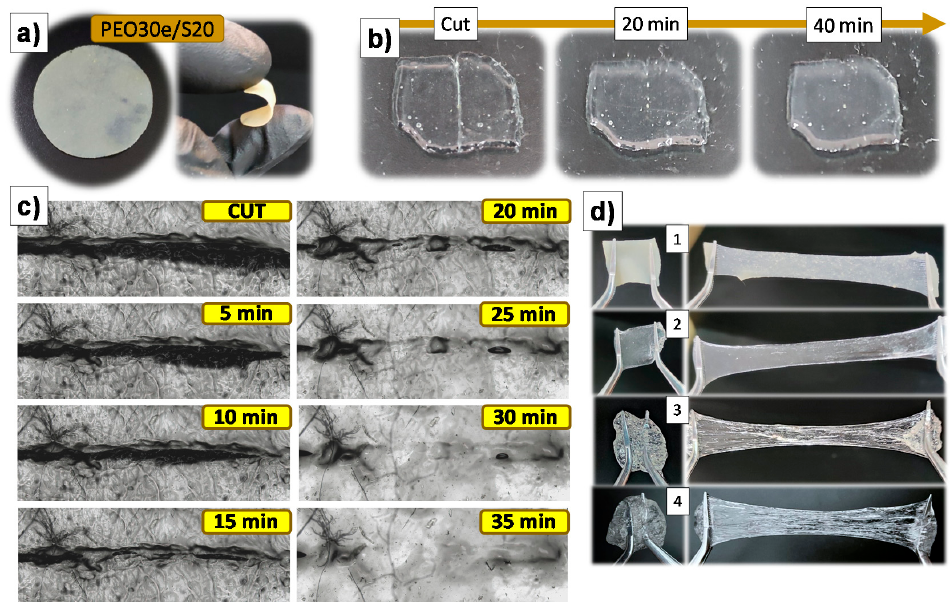
Figure 1. Pictures of the gels illustrating different properties: ( a ) films of flexible PEO30e/S20; ( b ) self-healing ability of PEO30e, and ( c ) optical profilometry images at 5× magnification of PEO30e, ( d ) stretching of PEO30e/S20 ( 1 ), PEO30e ( 2 ), PEO5e ( 3 ) and PEO5e/Na ( 4 ).